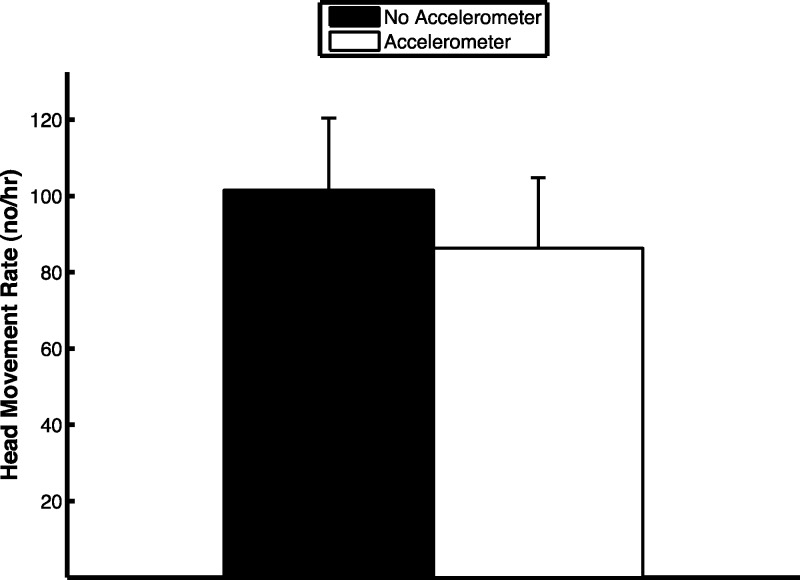
Head movement rate was similar regardless of whether the peahen was wearing an accelerometer or not (means ± SE).